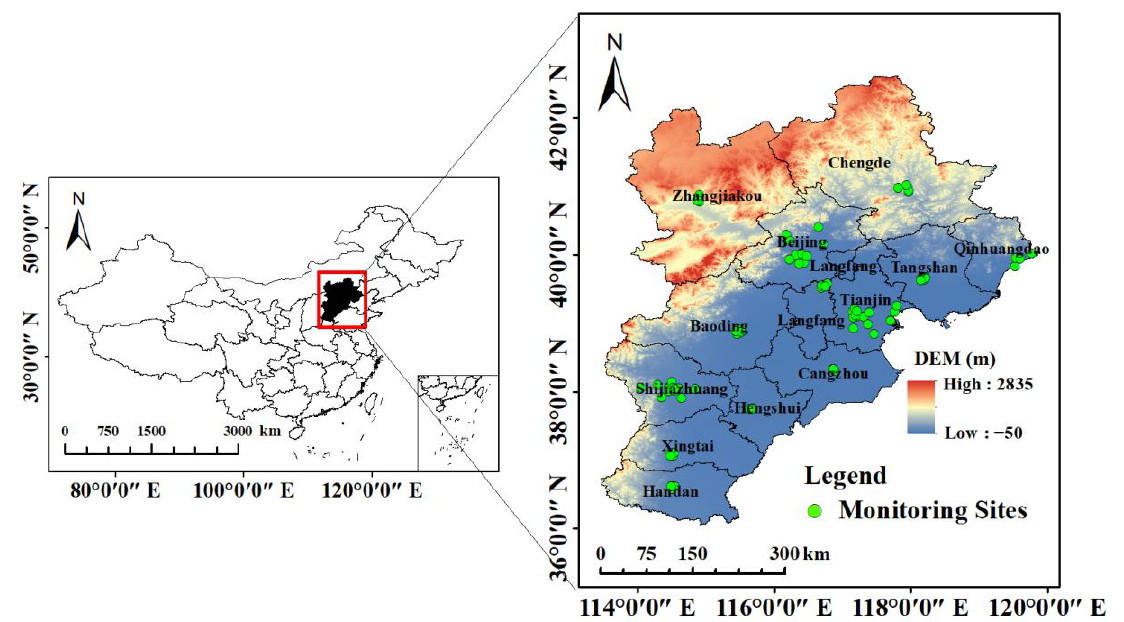
Figure 1. The distribution of O 3 monitoring sites and the topography in the BTH region.